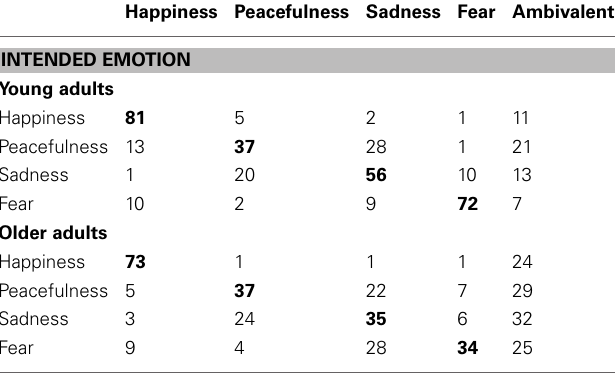
Table 3 | Mean percentage of the label that received the maximal rating of Emotion Felt by younger and older listeners as a function of the Intended Emotions.